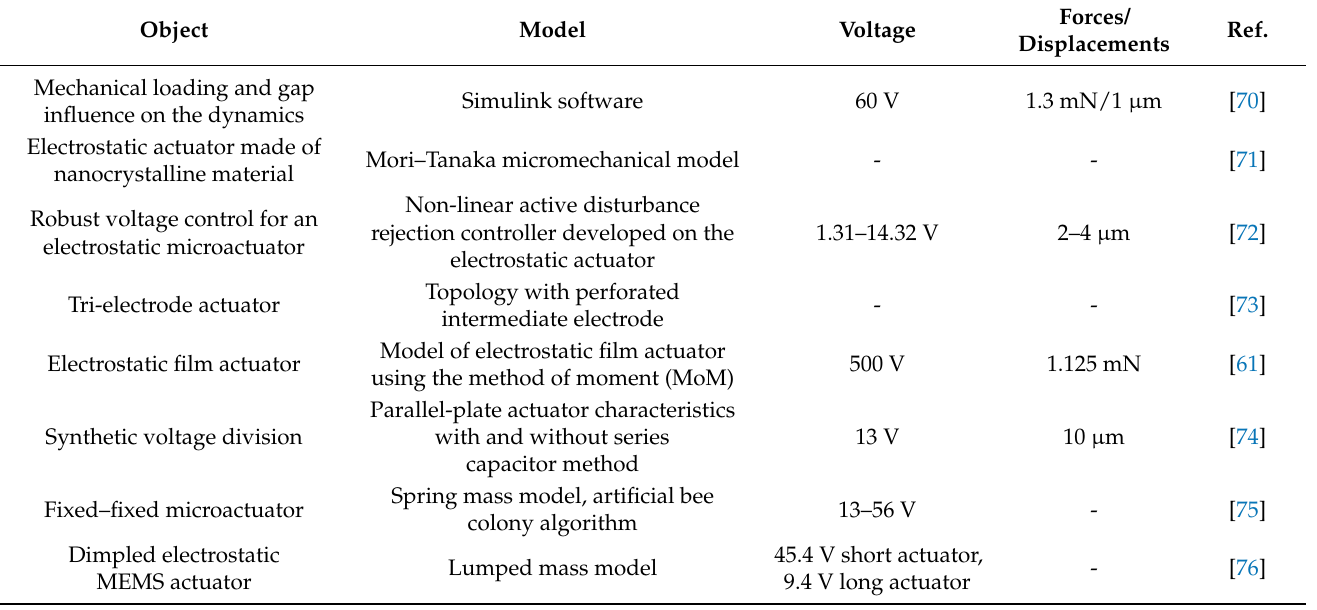
Table 3. Modeling of electrostatic actuators reported in last 5 years.